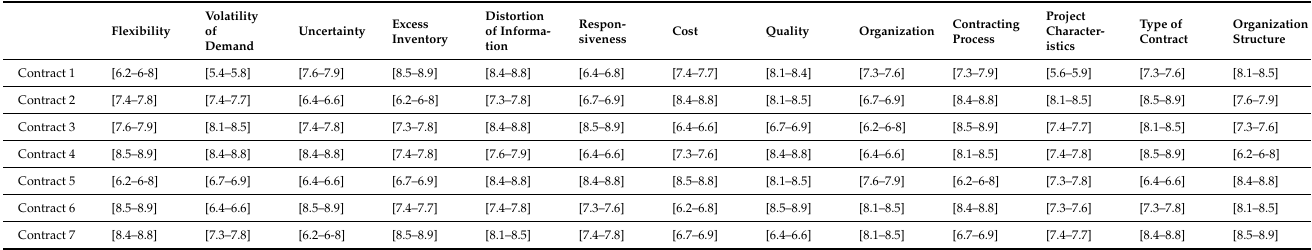
Table 11. Initial decision